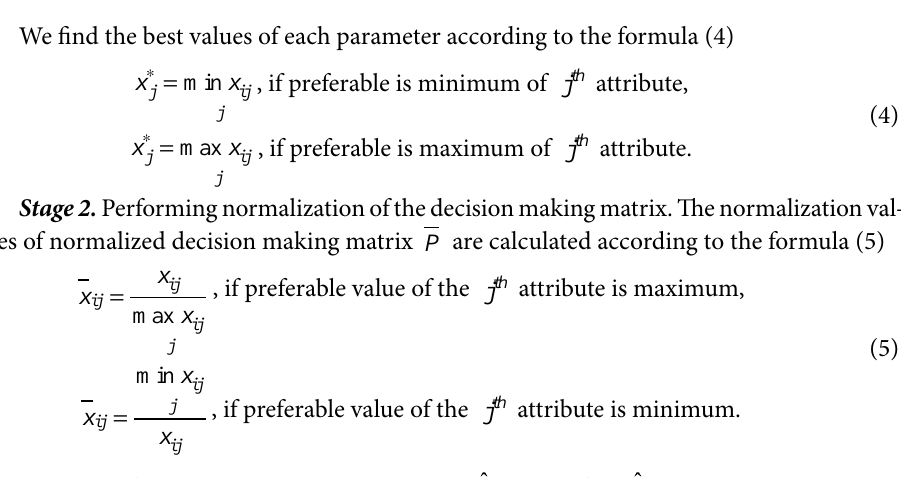
Fig. 2. The block the scheme of algorithm SAW for defying a rank of risk for alternative